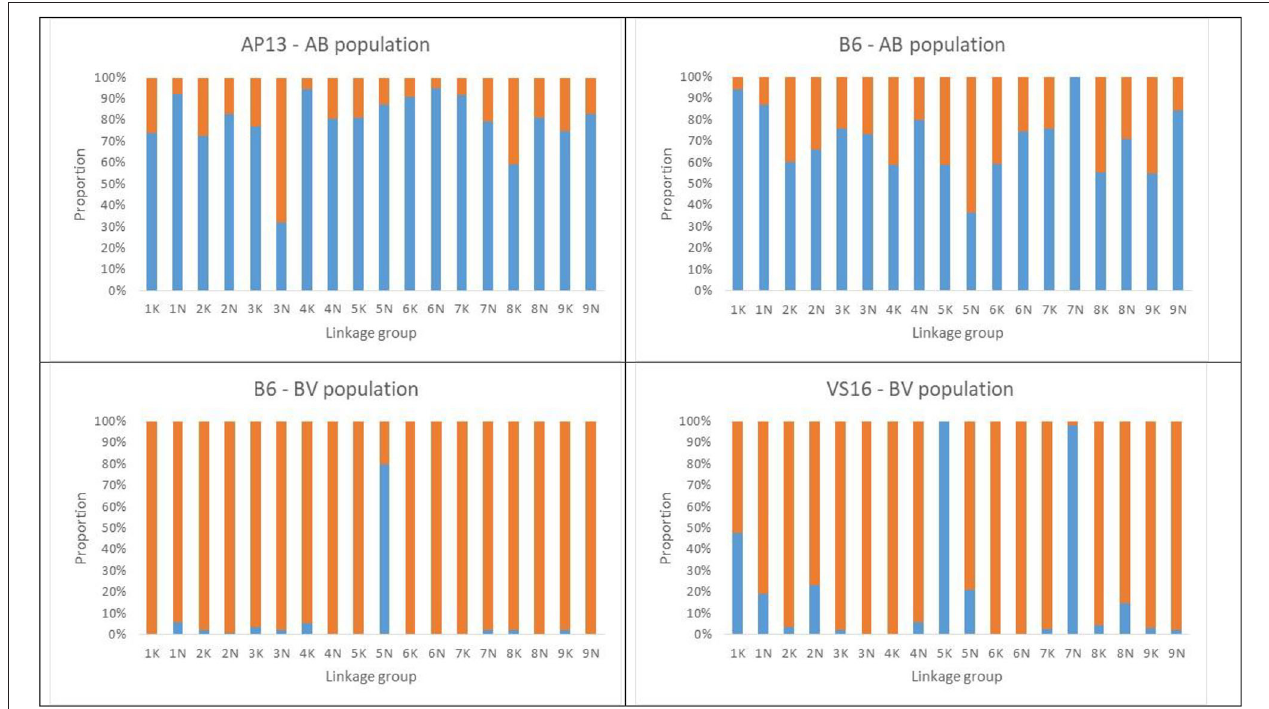
FIGURE 2 | Proportion of distorted (blue bars) and Mendelian markers (orange bars) across LGs assessed by the Chi-square ( X 2 ) values for the goodness-of-fit test to 1:1 expected segregation ratios ( p < 0.05).